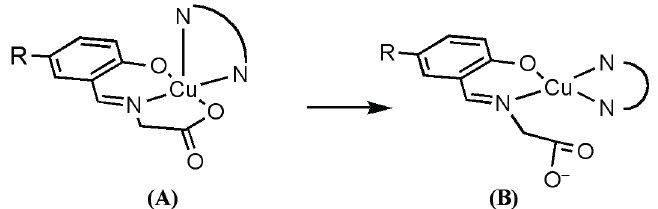
Figure 17. Proposed structural change in ternary Cu(II) complexes of cationic Schiff base and diimines on binding to DNA [60]. ( A ) Structure of the complex in crystal; ( B ) Structure of the complex intercalated to